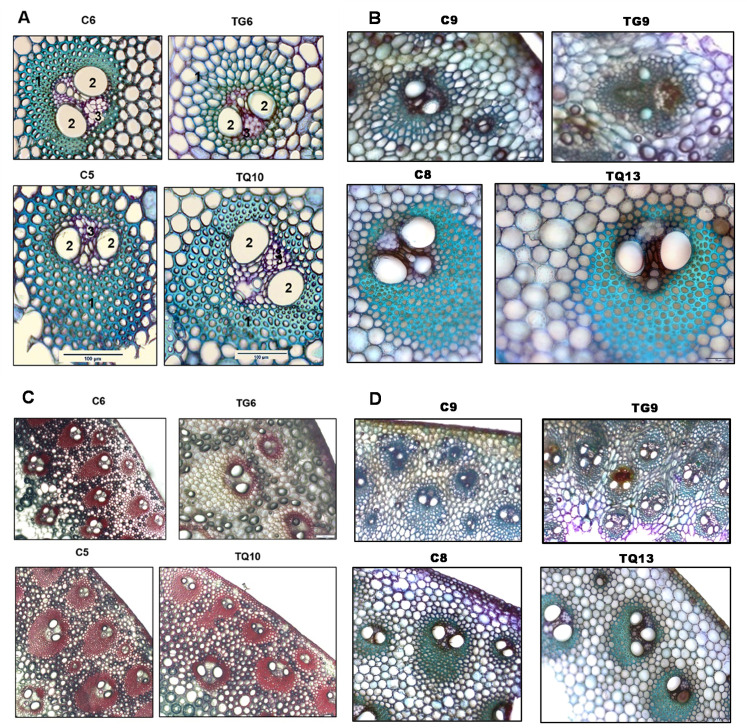
Stem morphology phenotypes of FAEA expressing TG and TQ plants at the VT tasselling stage of development.Transverse sections through the central vascular bundles of internode 6 of apoplast FAEA expressing plants TG6 and TQ10 (A,C), TG9 and TQ13 (B,D) and corresponding control plants (C6,C9, C5,C8) at high (20X) (A,B) and low (4X) (C,D) magnification, grown under greenhouse conditions to the VT tasselling stage of development, stained with either toluidine blue (A,B,D) or phloroglucinol (C). The sclerenchyma fibres (1), xylem vessels (2) and sieve elements (3) are indicated in (A). Bars = 100 μm.